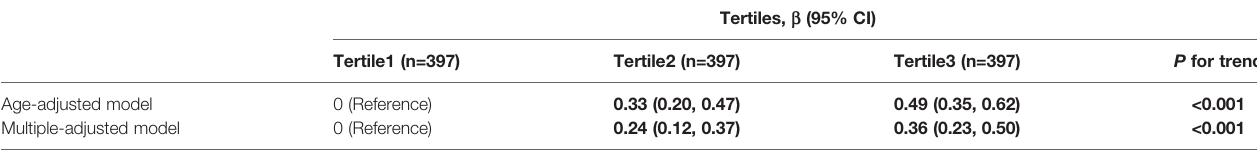
TABLE 2 | Multivariable adjusted b and 95% con fi dence interval (CI) for body mass index (BMI) z-scores across C1q tertiles.